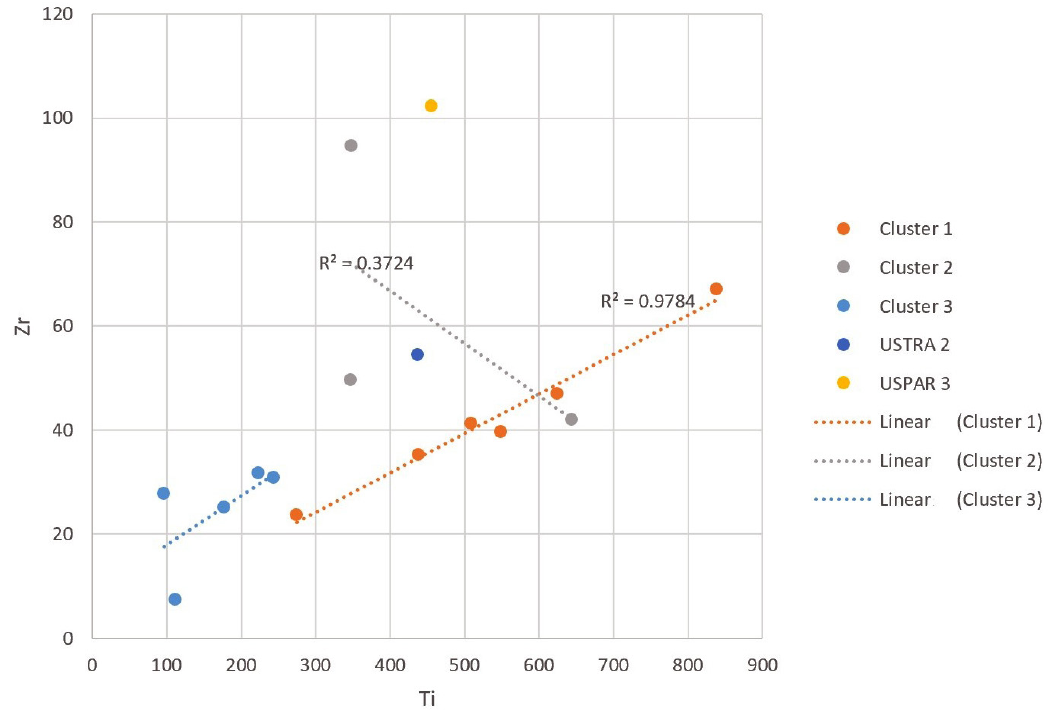
Figure 11: Correlations of titanium and zirconium in three clusters.